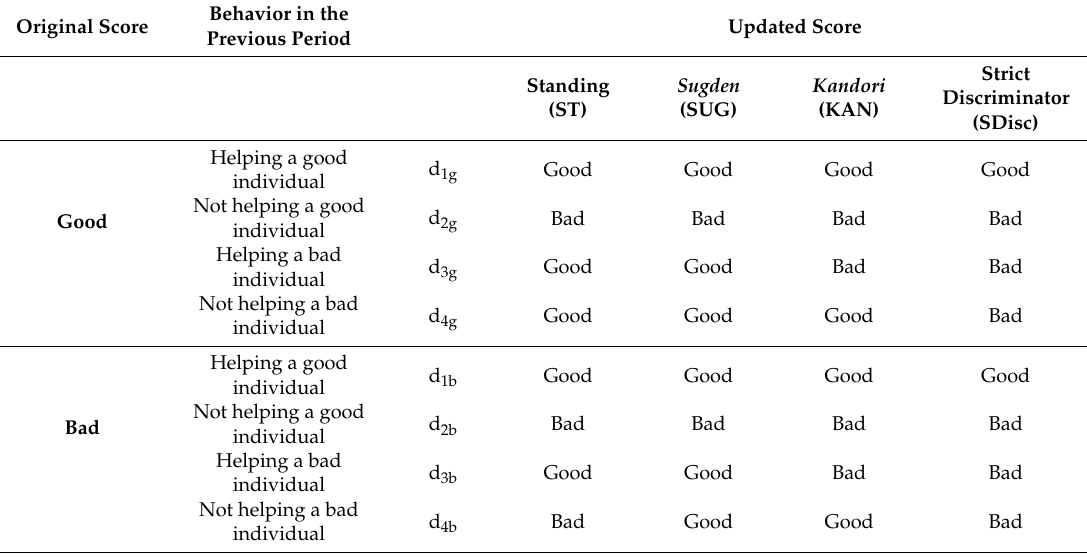
Table 1. Assignment of reputation scores.